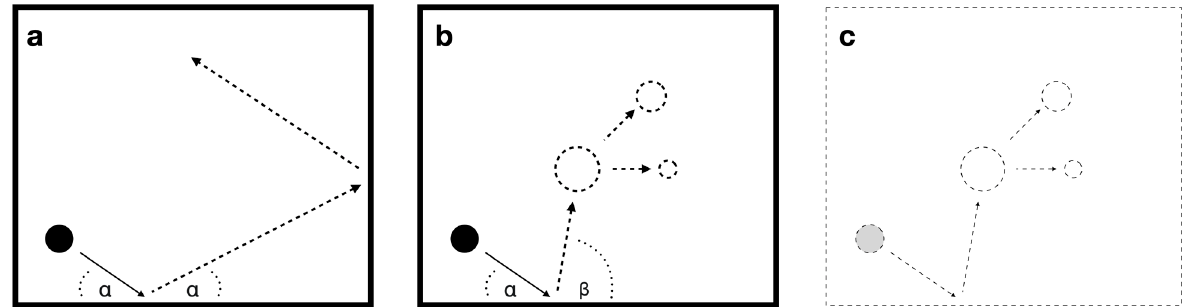
Figure 3. ( a ) Model-world in which the same laws of conservation apply as in the real world, ( b ) Model-world degraded by gradually abolishing the laws of conservation, whose evolution becomes increasingly chaotic, and ( c ) By completely suspending the laws of conservation, the continuity of the observer is also abolished, as part of the integral observer-world system.